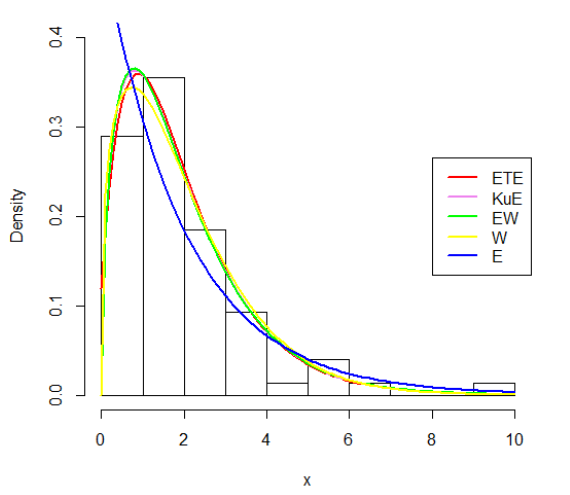
Figure 7 – Fitted pdf plots of first data